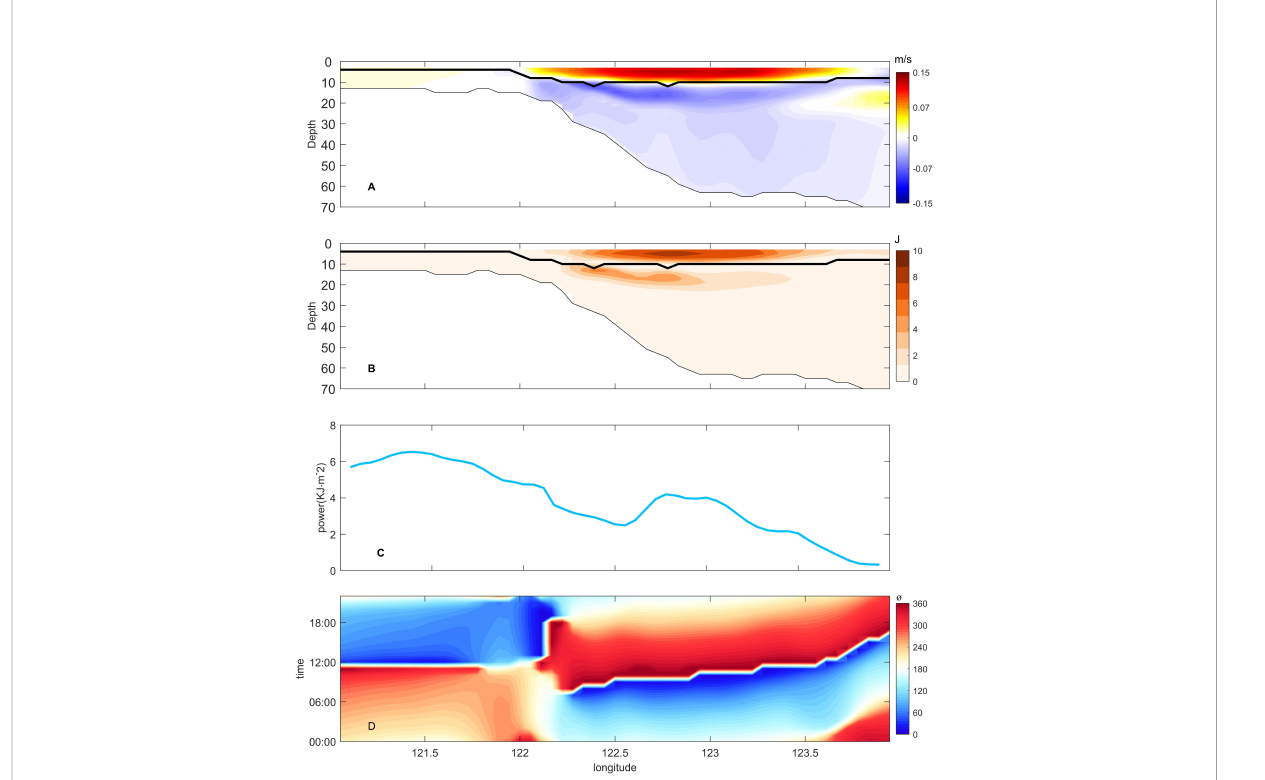
FIGURE 10 (A) Horizontal distribution of near-inertial velocity (m/s) at 12:00:00 on 11th August 2015 at 34°N from ROMS. (B) is the same as (A) but for averaged NIKE (J). (C) Zonal distribution of wind energy input (KJ·m -2 ). (D) Zonal-time plot of phase (theta =actan ( v f u line in (A, B) represent the maximum strati fi cation depth and water depth,